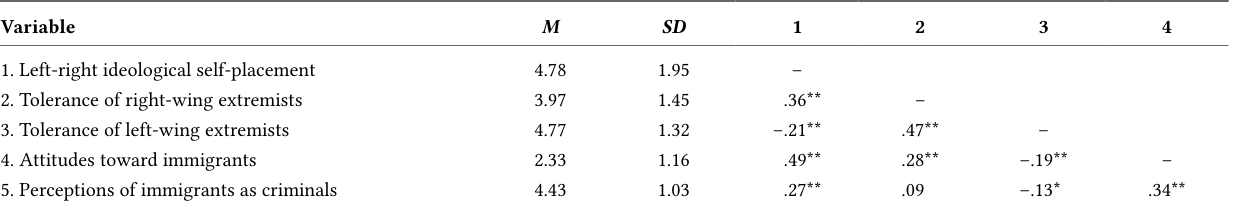
Descriptive Statistics and Pearson Correlations for the Continuous Variables in Experiment 2